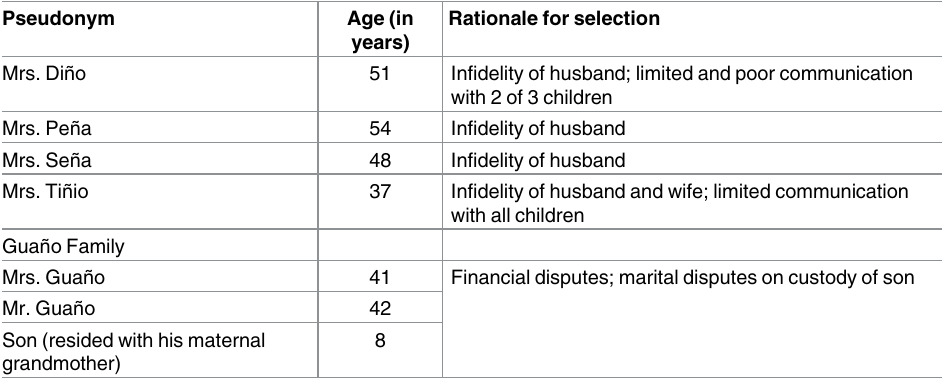
Table 2. Demographic information about non-resilient